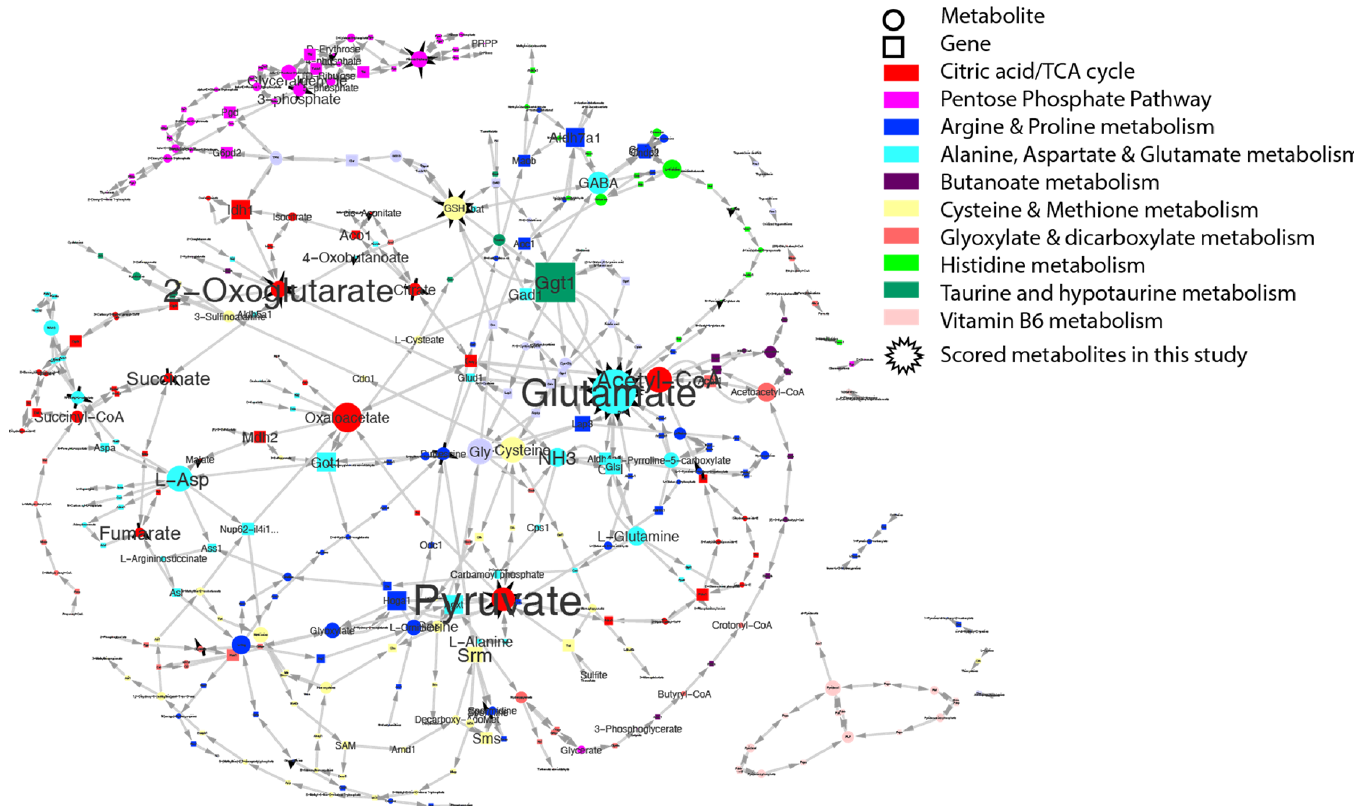
Fig 4. Potential metabolism targets of metformin revealed in this study. KEGG metabolism pathways enriched in this study (Table 1) were merged in a focus network. The font size of each node reflects the connectivity weight (number of edges) in this focus network. Each node represents either a metabolite (circle) or a protein (square). The edges indicate directions of biochemical interactions in this network. Plot was generated in Cytoscape.